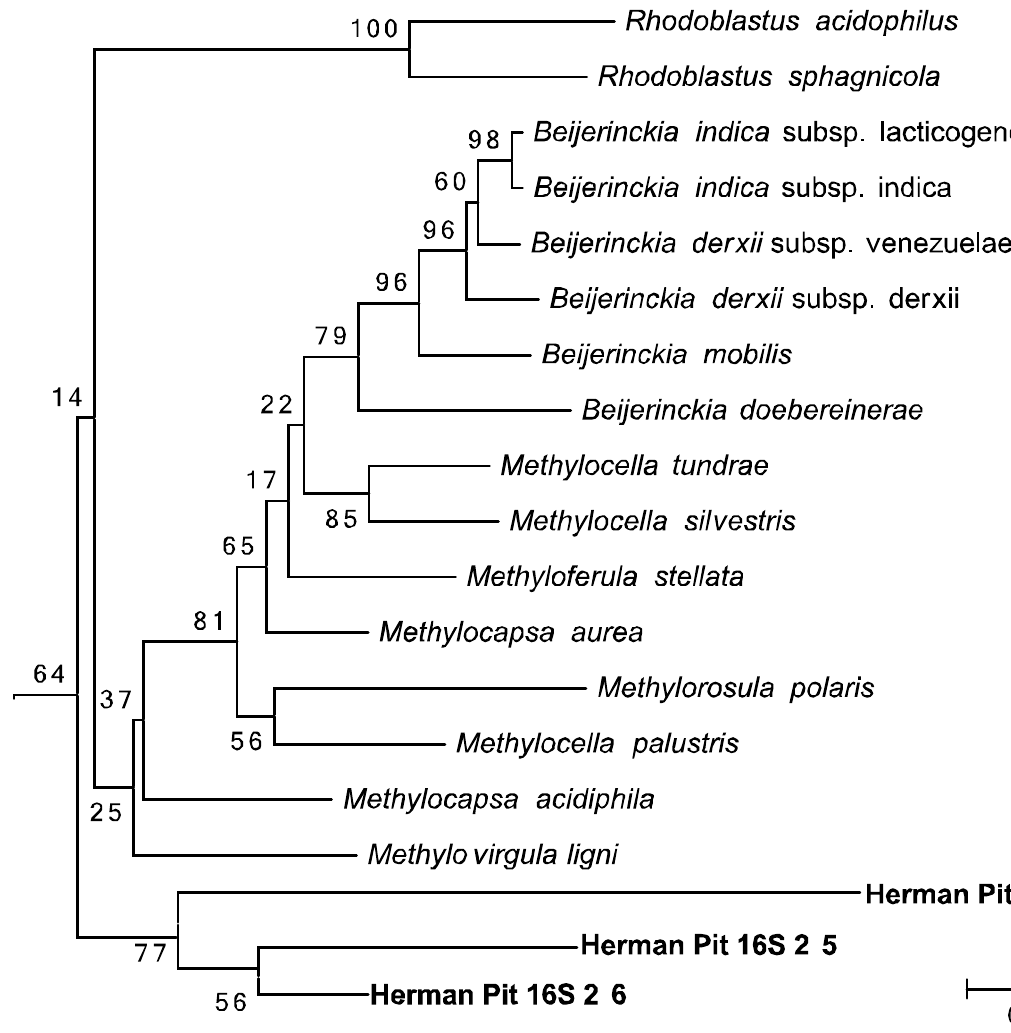
Figure 6. Neighbor-joining tree of three 16S rRNA gene amplified from the Herman Pit enrichment sample demonstrating their close relationship to the Alphaproteobacterial class of aerobic